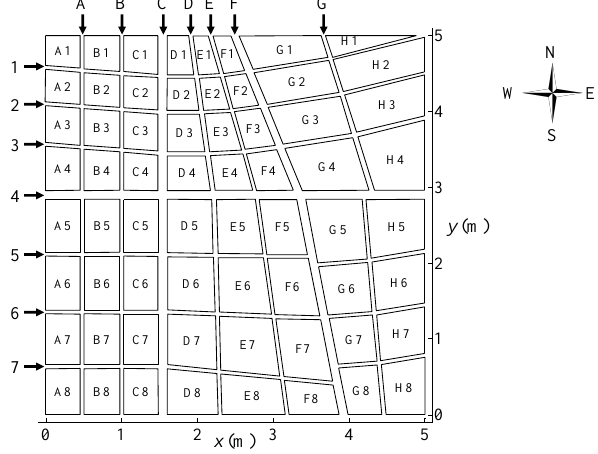
Figure 1. Plane view of the idealized urban district considered in the experiments. Adapted from Araud